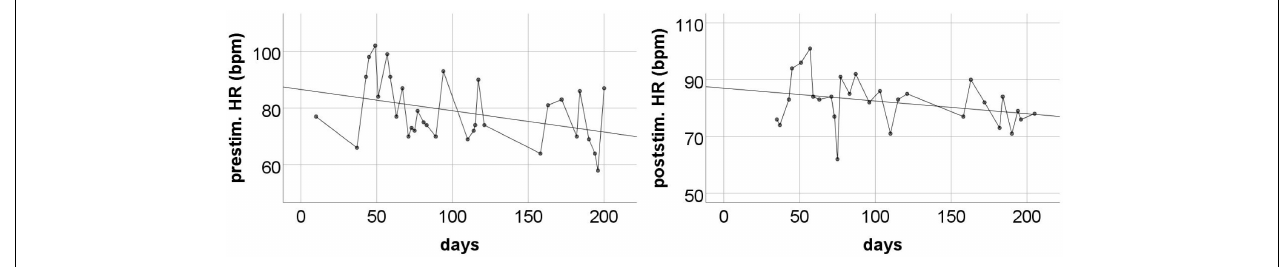
FIGURE 4 | The pre-stimulation (left panel) and post-stimulation (right panel) HR levels from all measurements during the entire program period. Solid line is the best fitted regression line (mathematical description in Table 4 ).